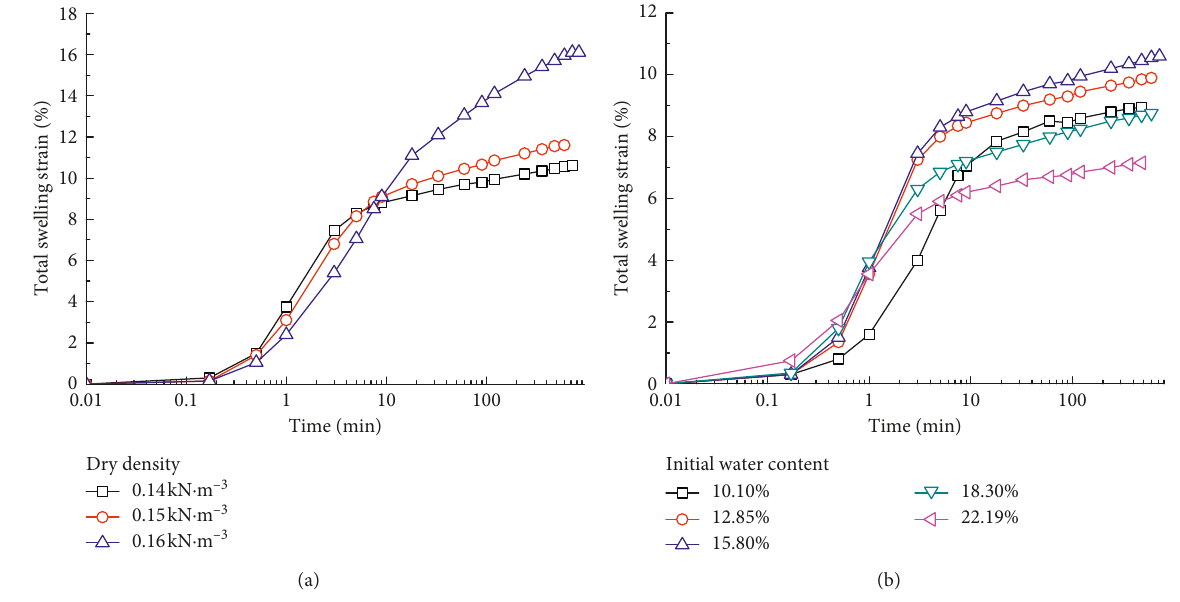
Figure 6: Relation of expansive deformation and log time. (a) Water content of 15.80%. (b) Dry density of 0.14kN/m 3 . Table 2: Coefficients of primary swelling and secondary swelling for an initial moisture content of 15.8%.